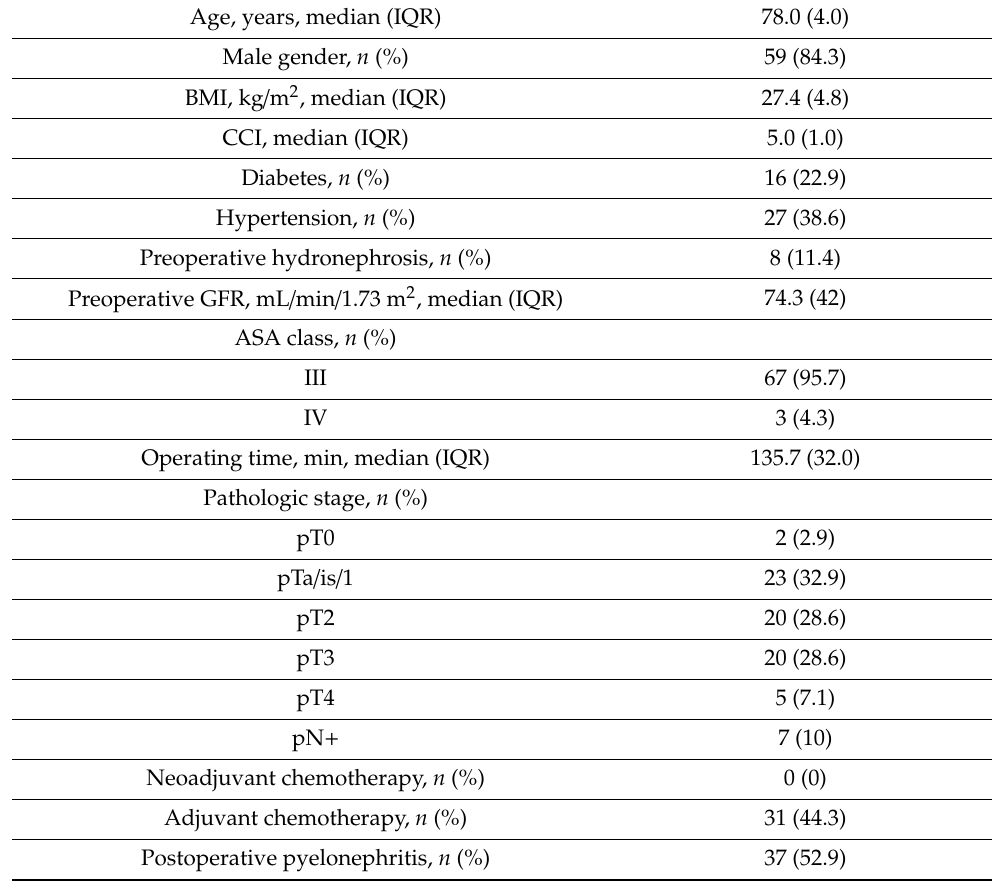
Table 1. Demographic and some clinical characteristics of the whole